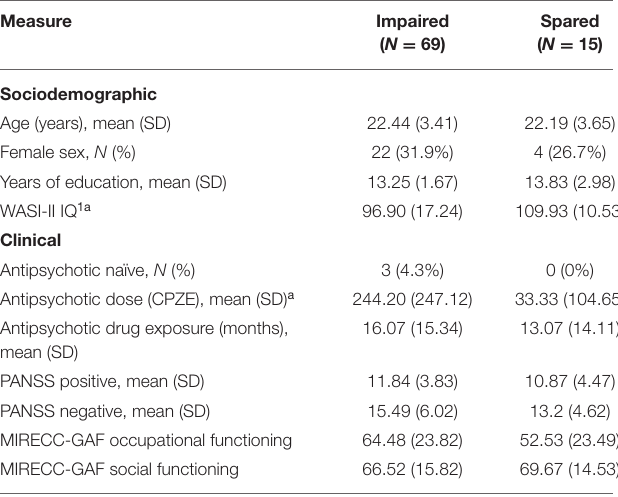
TABLE 1 | Demographic and clinical characteristics of the cognitive subgroups of schizophrenia patients. Measure